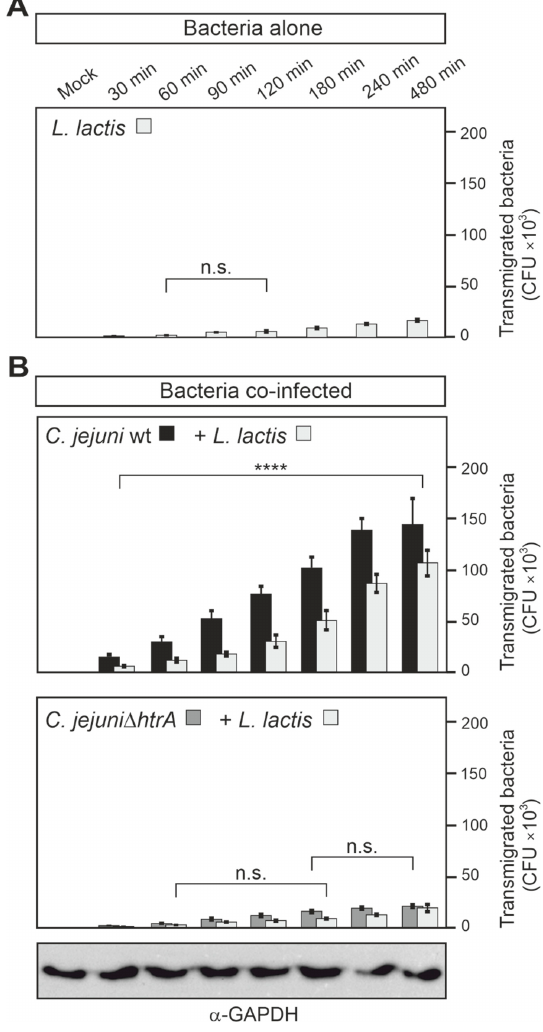
Figure 5. Time course of transmigration properties of C. jejuni and L. lactis bacteria across polarized Caco-2 cells using a transwell filter system. Caco-2 cells were cultivated for 14 days to form polarized monolayers on transwell filters and then infected with the indicated single L. lactis strain ( A ) or mixed bacterial strains ( B ) at an MOI of 25 each. Transmigrated bacteria were collected from the bottom chambers. C. jejuni were grown on Campylobacter agar plates and L. lactis on MRS agar plates. Finally, the CFUs were quantified in triplicate. On the bottom is a representative GAPDH blot as a loading control. Significant differences shown in the graphs correspond to p ≤ 0.0001 (****) or non-significant